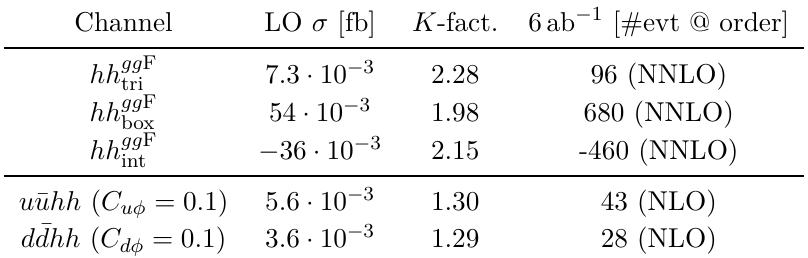
Table 2 . The LO SM cross-section for di-Higgs production at the HL-LHC for 6 ab − 1 of data multiplied by the hh → b ¯ bγγ SM branching ratio, K -factors (taken from [77] for the gluon channels and [27] for the quark channels) and the number of events after the basic cuts for the gluon √ fusion ( gg F) and quark annihilation ( q ¯ qhh ) at s = 14